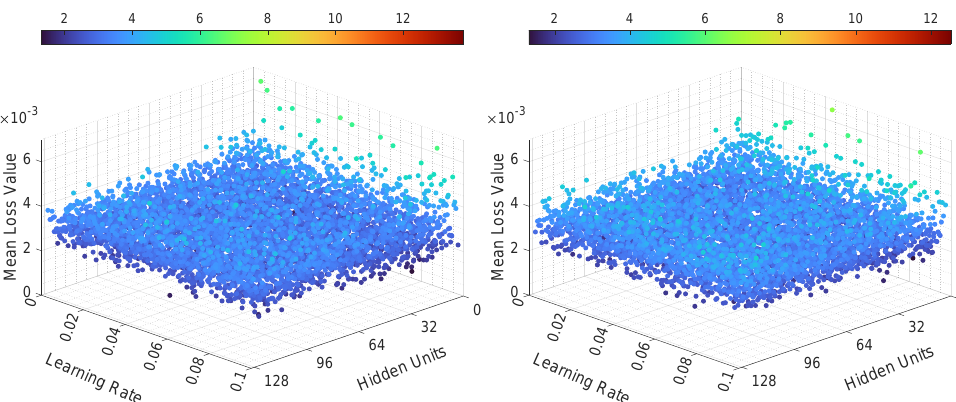
Figure 11. Illustration of the mean loss value for Experiment 3, LSTMTF ( left ) and VLSTM ( right ), using a many-to-one prediction